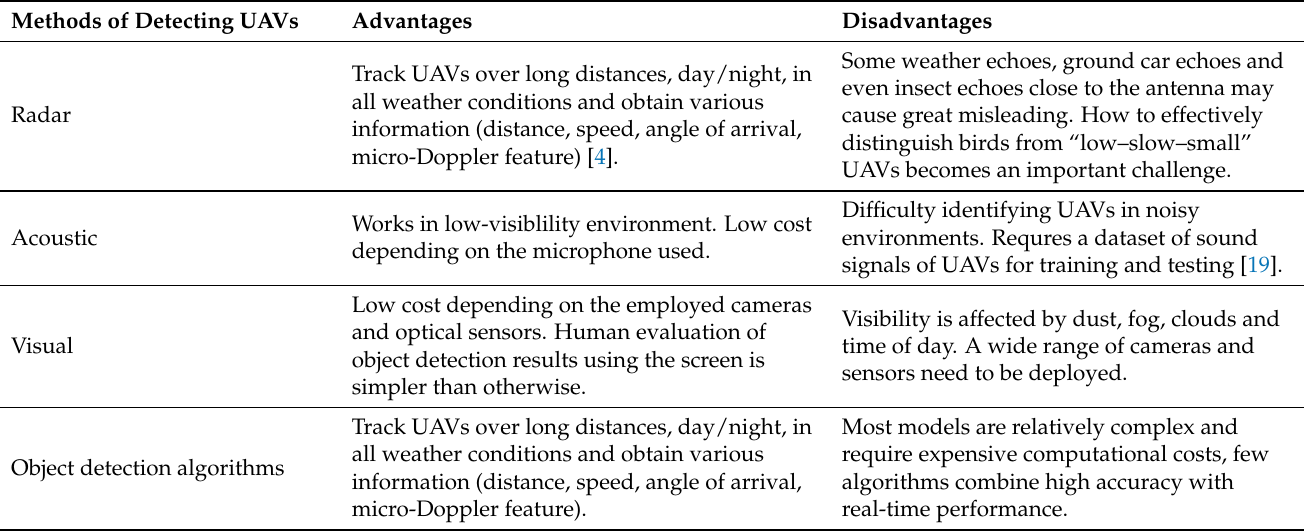
Table 1. Methods of detecting UAVs.